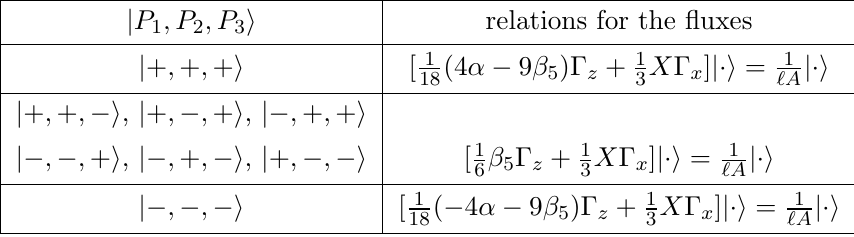
Table 7 . Decomposition of (4.66) KSE into